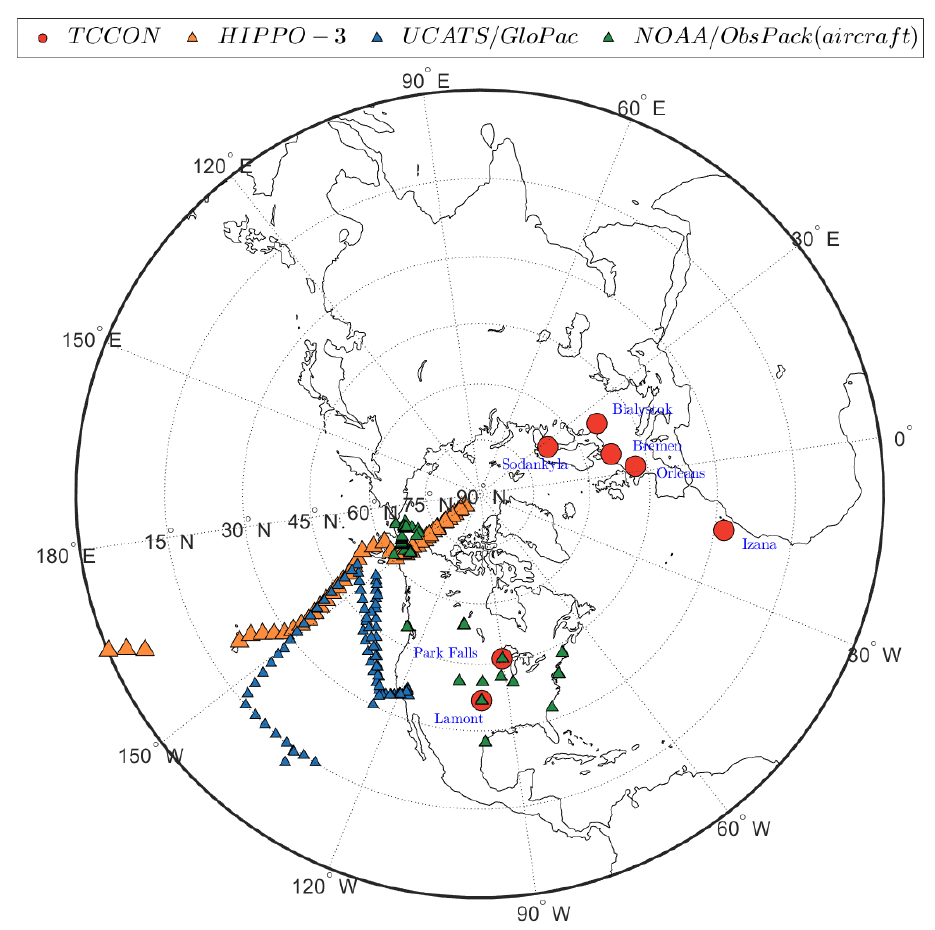
Figure 7. Methane measurement data used for the evaluation of the assimilation system in April 2010: TCCON stations (red circles) at seven sites; HIPPO-3 aircraft measurement pathways (orange triangles) on 10, 13 and 15 April 2010; UCATS/GloPac aircraft measurement pathways (blue triangles) on 7 and 13 April 2010; and NOAA/Obspack aircraft measurements (green